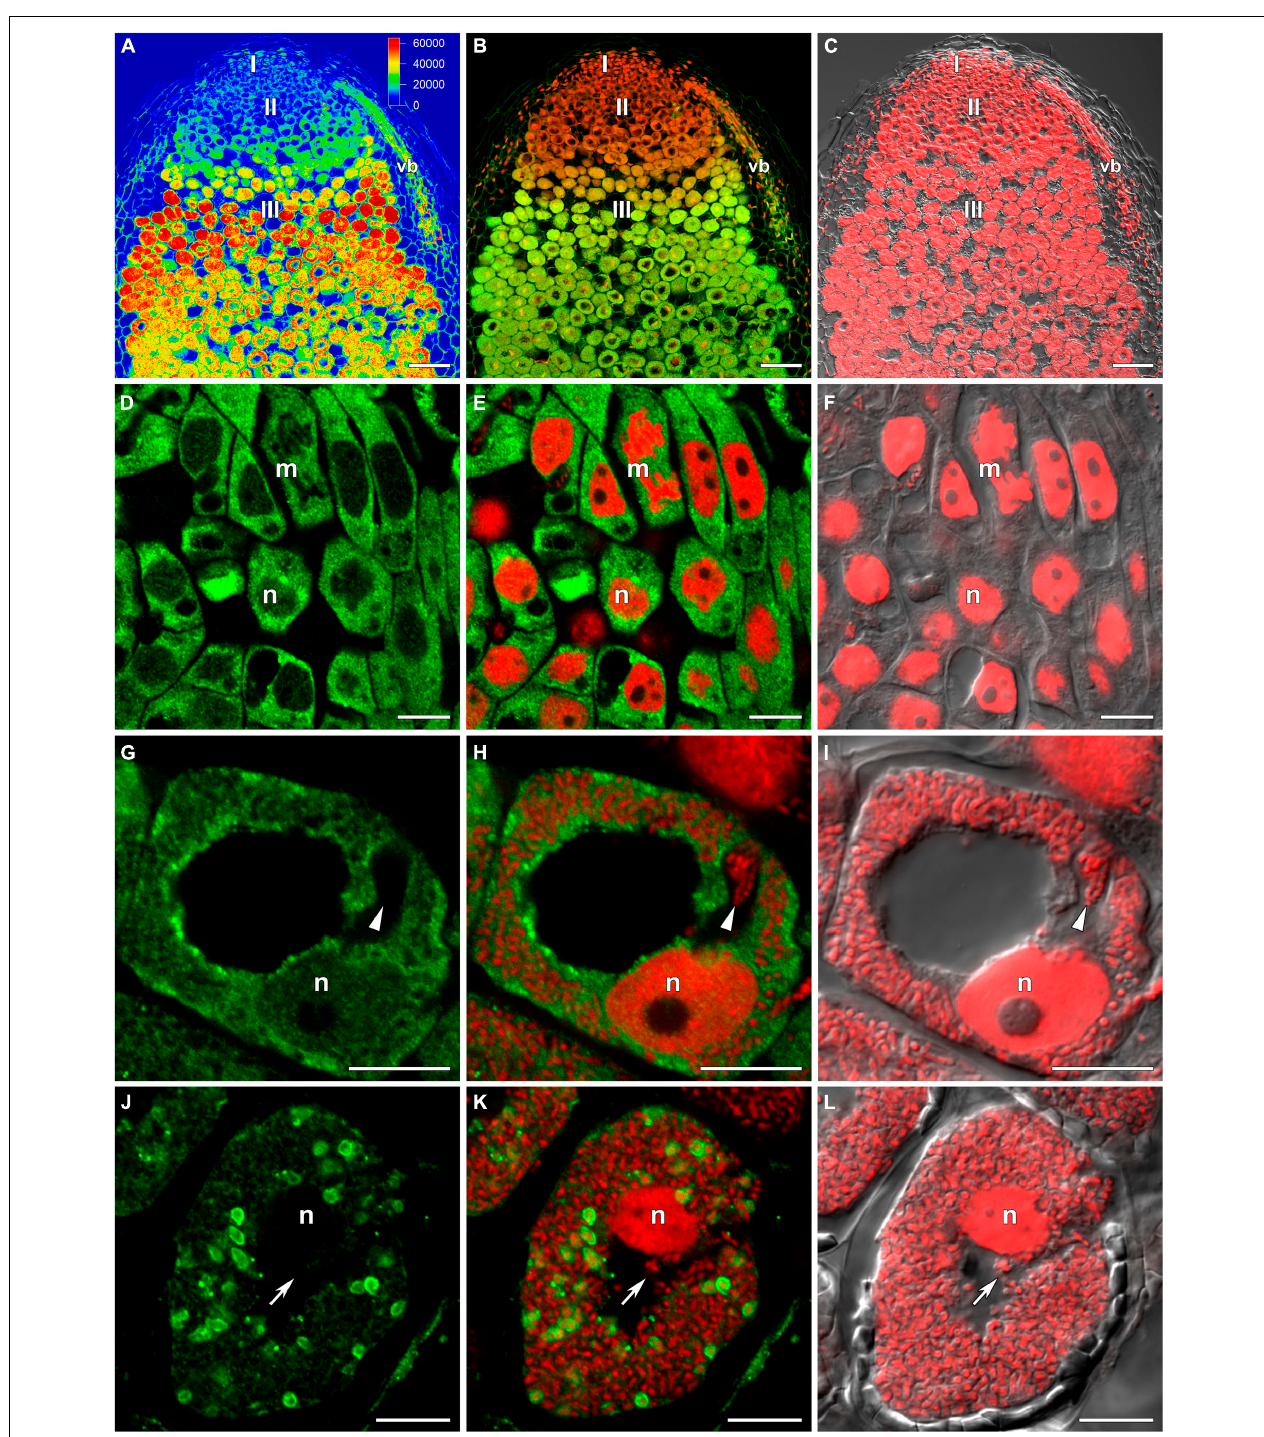
FIGURE 1 | Immunolocalization of glutathione in 3-week-old nodules of wild-type pea ( Pisum sativum ) using a rabbit anti-glutathione (reduced) antibody. (A–C) General view; (D–F) meristem; (G–I) cells from the late infection zone; (J–L) infected cells from the nitrogen fixation zone. (A) Heatmap showing color-coded fluorescence signal intensities for the green channel; (D,G,J) green channel; (B,E,H,K) merge of the green and red channels; (C,F,I,L) merge of differential interference contrast and the red channel. Confocal laser scanning microscopy images of 50- µ m-thick longitudinal sections. A single optical section is presented, glutathione in green and DNA (bacteria and nuclei) in red. I, meristematic zone; II, infection zone; III, nitrogen fixation zone; vb, vascular bundle; m, mitosis; n, nucleus. Arrows indicate infection threads; arrowheads indicate infection droplets. Scale bars = 100 µ m (A–C) and 10 µ m (D–L) .